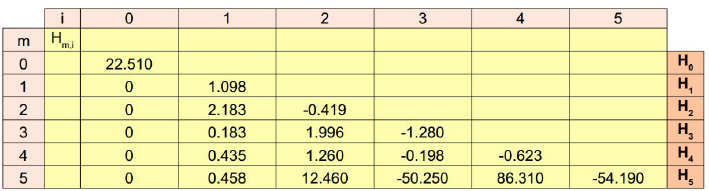
Figure 3. Values of the H m , i numerical coefficients in Equation (10). For each candidate function all the values of each H m vector are reported in lines. These values are the numerical coefficients needed to provide the linear combination of JHS i ( t ) functions to express each w m ( t )